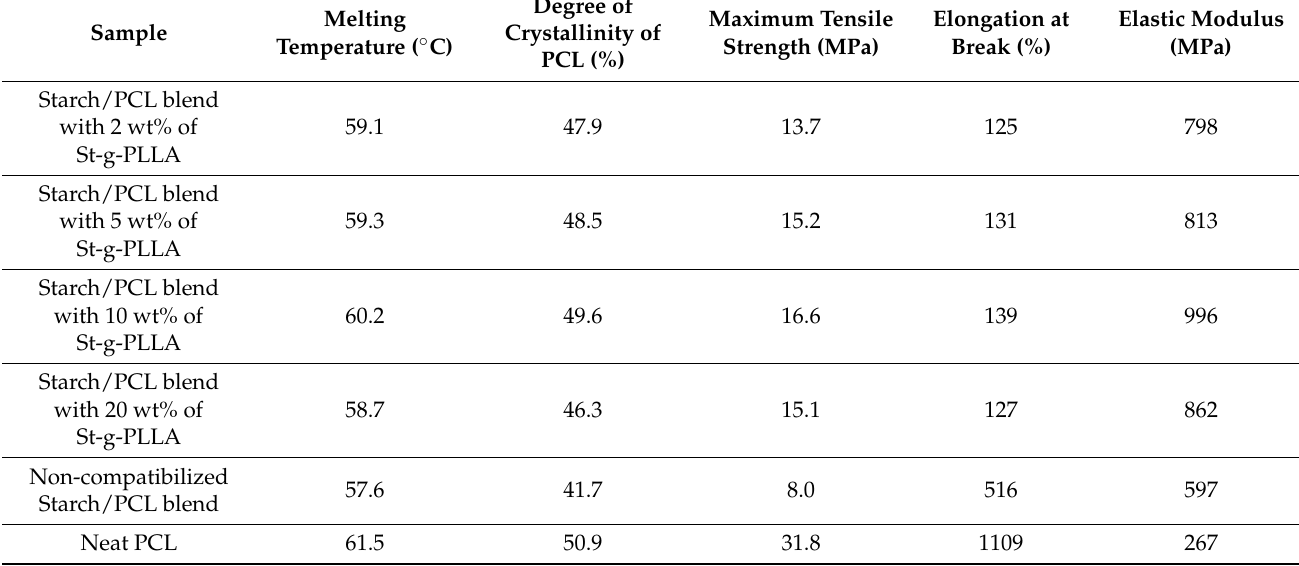
Table 3. The variation of thermo-mechanical properties and the degree of crystallinity of PCL in Starch/PCL blends [63].